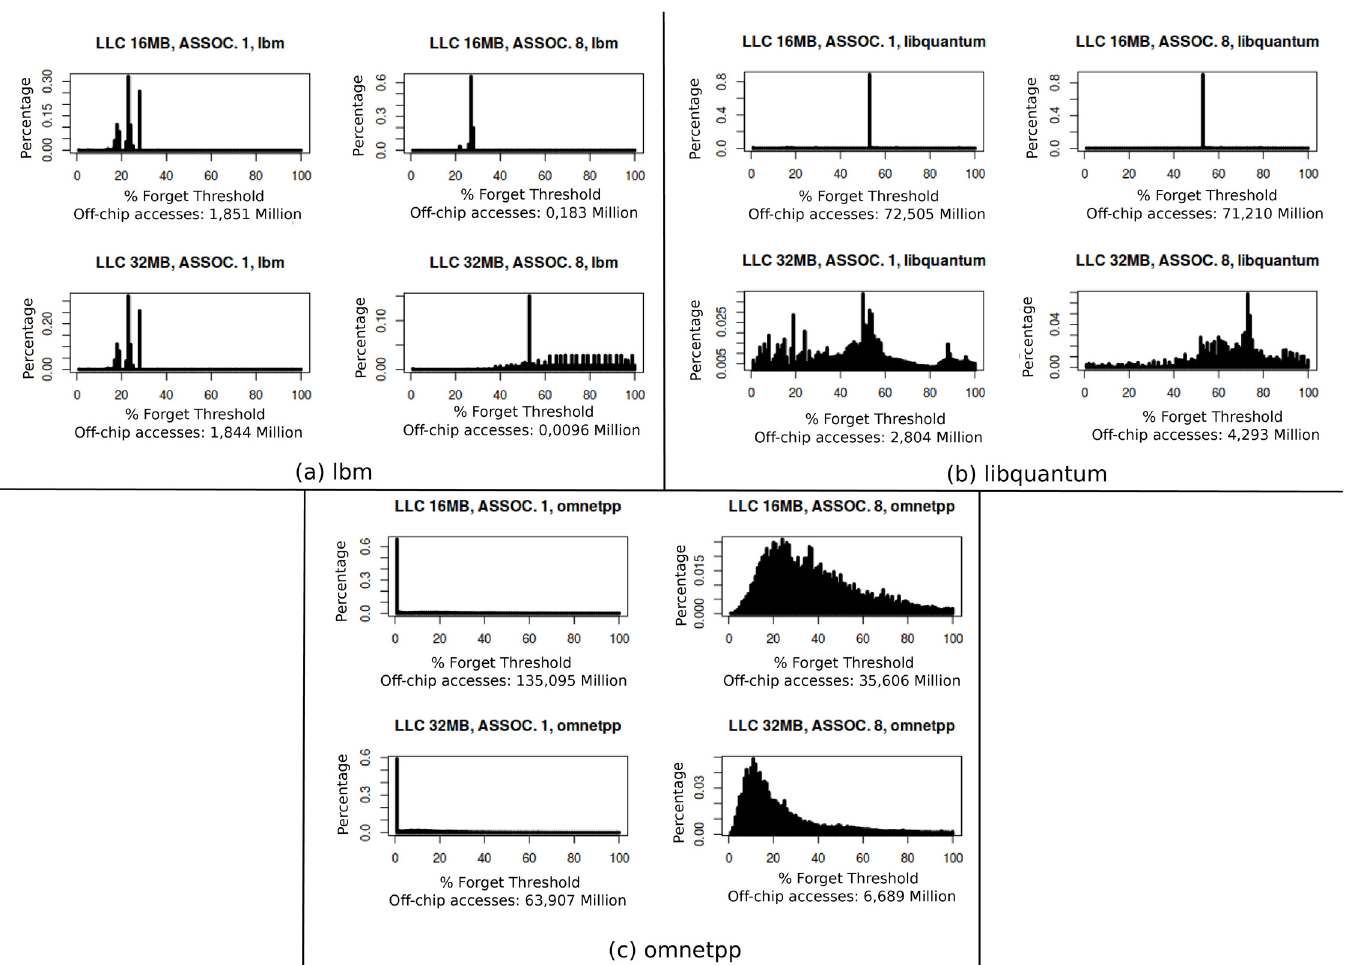
Fig 1. TL with four LLC configurations. Temporal locality of lbm , libquantum and omnetpp , represented as time interval probability between consecutive accesses (100 in this figure is the forget threshold), with four different LLC configurations: Size 16MB-32MB and associativity 1-8. The number of off-chip accesses is included showing the ability of LLC to filter cache